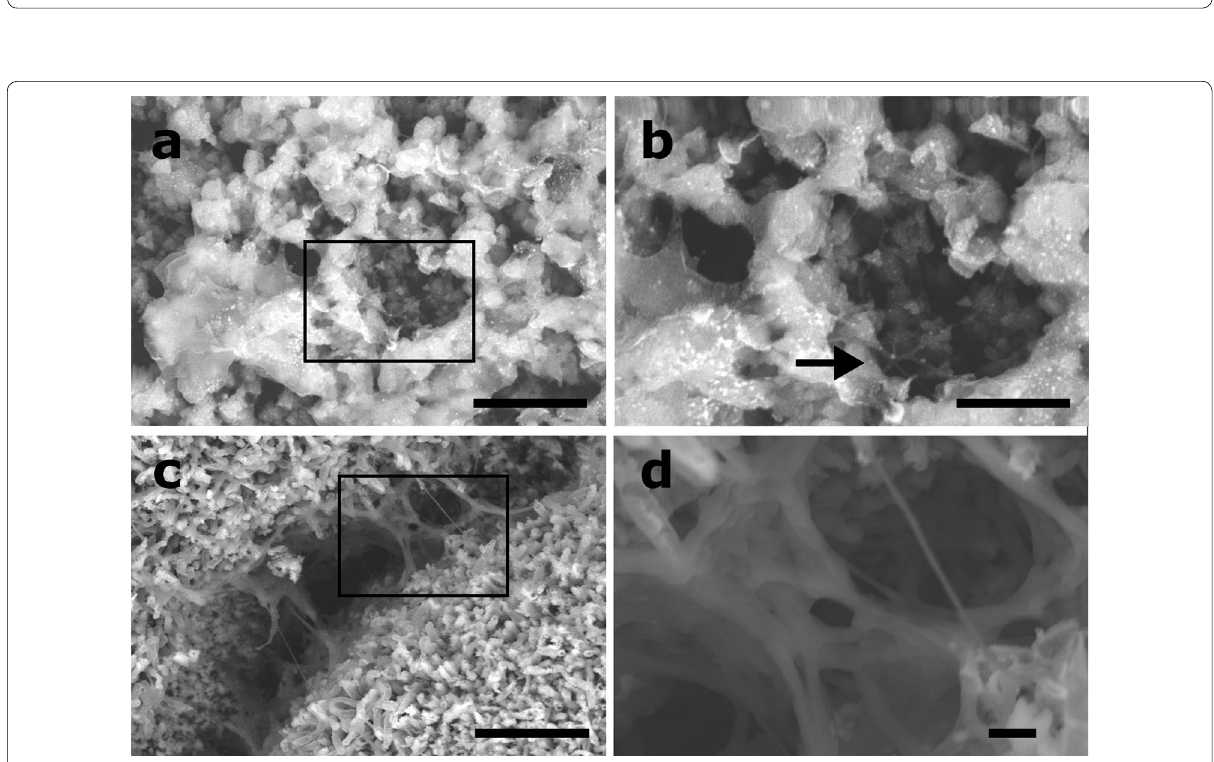
Fig. 5 Mineralized micro and nanofibers of BCC‑EPS. SEM images of a BBC‑GLC and c BCC‑LAC are shown. The rectangles ( b , d ) indicate its respective magnifications, and nanofibers are pointed out (black arrow). Scale bars: 10 µm ( a ) and 1 µm ( b ), and 1 µm ( c ) and 0.5 µm ( d